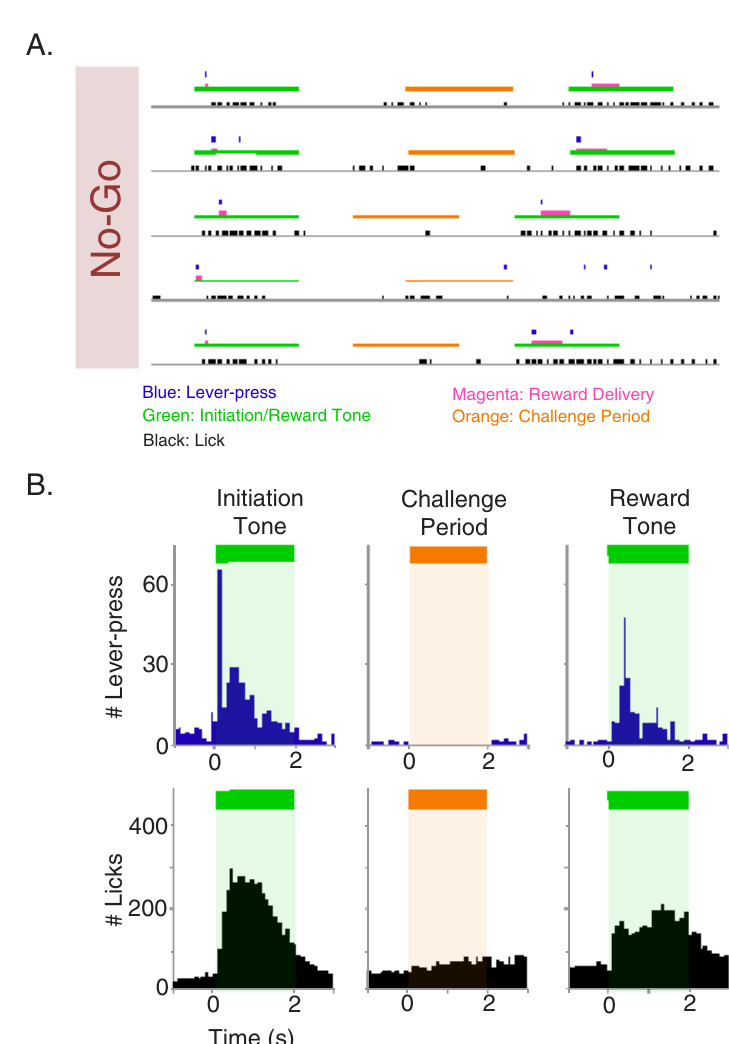
Figure 3. Raster plot of five consecutive No-Go trials ( A ) and histograms of lever pressing and licking during initiation tone, challenge period, and reward tone ( B ). Green bar: initiation tone and reward tone, orange bar: challenge period, magenta bar: reward delivery, black: lick, blue: lever press. (Histogram bin size=100